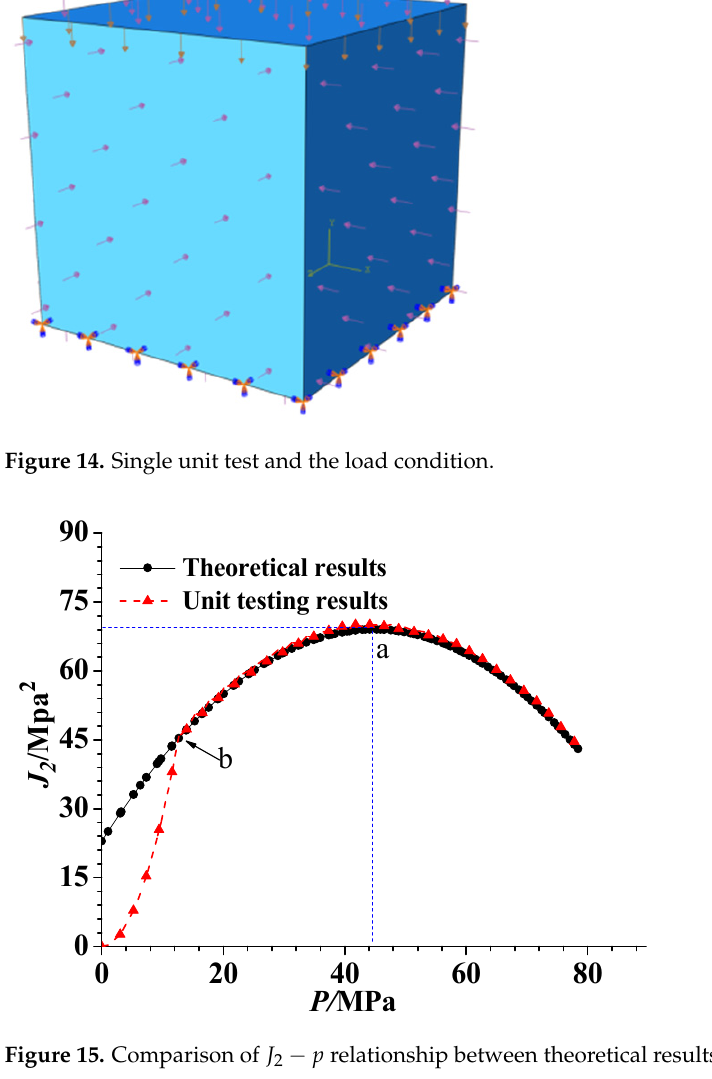
Figure 16. Comparison of